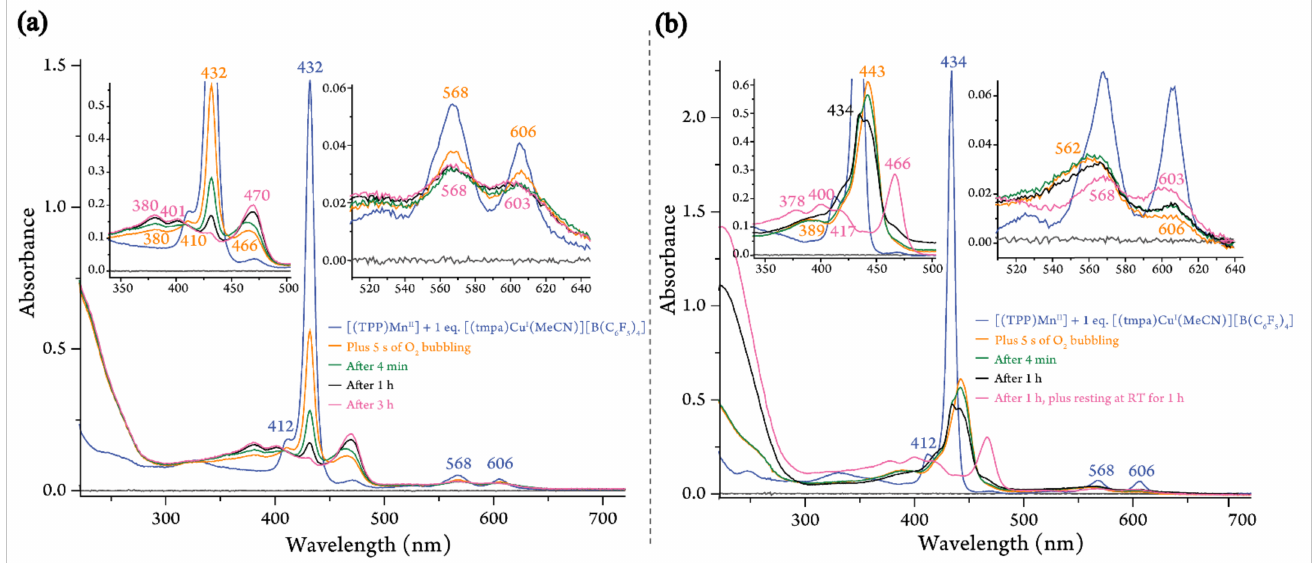
Figure 2. UV-vis spectra of the oxygenation reaction of 1:1 mixture of [(TPP)Mn II ] and [(tmpa)Cu I (MeCN)][B(C 6 F 5 ) 4 ] in MeTHF in a 4-mm cuvette at: ( a ) room temperature (7 µ M), and ( b ) − 110 ◦ C (8 µ